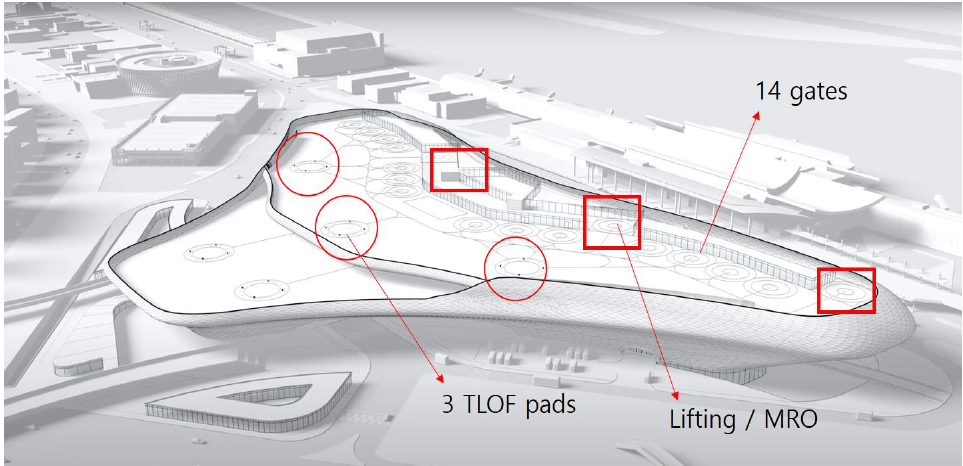
Figure 42. The upper deck design of the Gimpo Airport vertihub [21].